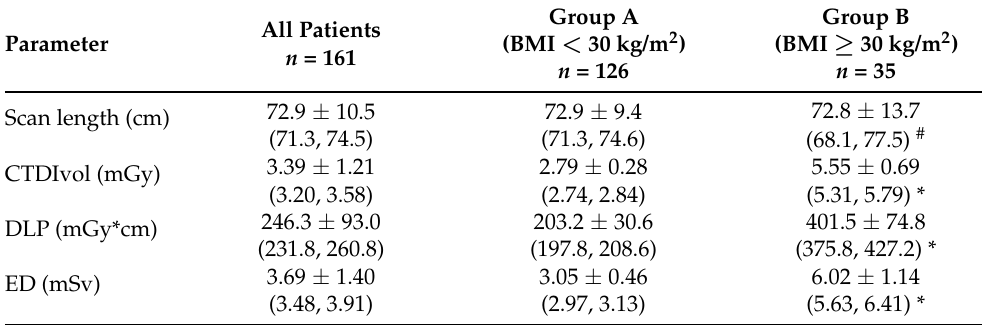
Table 5. Fifty patients had received both the low-dose CTA protocol and the clinical routine CTA protocol with equal scan range, the same CT scanner and the same contrast medium, and thus were included into the intraindividual comparison. Table 5. Radiation dose evaluation of the low-dose CTA protocol. All Parameter